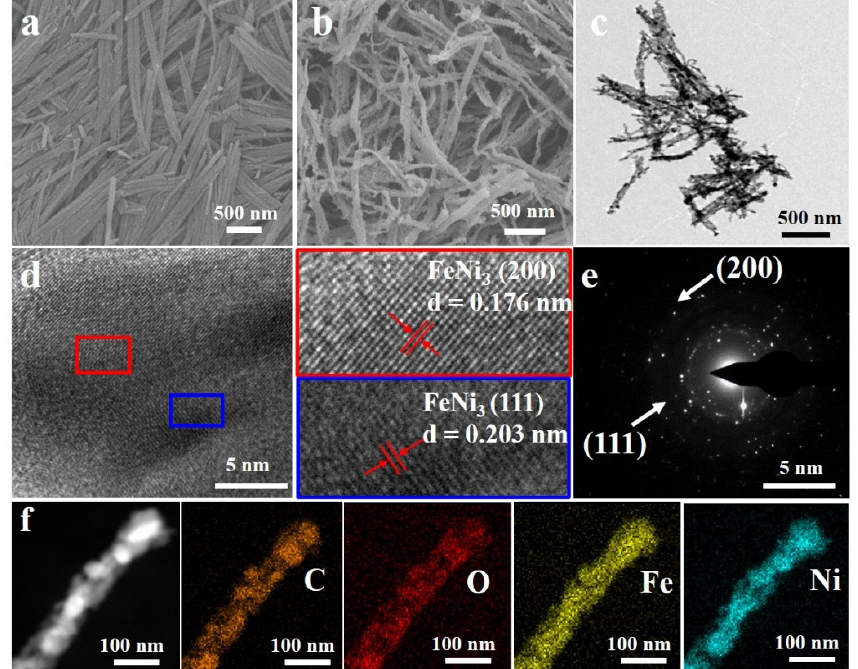
Figure 1. SEM images of ( a ) FeNi and ( b ) FeNi 3 /C nanorods; ( c ) TEM and ( d ) HR-TEM images of FeNi 3 /C nanorods; ( e ) SAED pattern; ( f ) STEM and elemental mappings of the FeNi 3 /C nanorods. The change in the crystal structure of FeNi 3 /C was characterized by X-ray diffraction (XRD) (Figure 2a). The broadened peak at 25.8° corresponded to the (002) plane of gra- phitic carbon. The characteristic peaks for the FeNi nanorods were indexed to the exist- ence of NiFe 2 O 4 (JCPDS card No. 54-0964). In comparison, the FeNi 3 /C nanorods showed strong characteristic peaks at 44.2°, 52.0°, and 75.7 o , owing to the (111), (200), and (220) planes of the FeNi 3 alloy (JCPDS card No. 38-0419), which is agreement with the TEM results. The disappearance of the diffraction peaks of NiFe 2 O 4 for FeNi 3 /C was attributed to the decomposition of metal oxides during thermal activation. Meanwhile, the effect of XRD analysis (Figure S3b), and the average crystal size of the FeNi 3 / nanorods was ap- proximately 15.6 nm. As the activation temperature increased, the domain characteristic peaks of the FeNi 3 /C nanorods became stronger than for FeNi 3 /C-300, indicating the in- in the characteristic peaks between FeNi 3 /C and FeNi 3 /C-500, demonstrating that the op- timal temperature of 400 °C was high enough to form a stable catalyst.